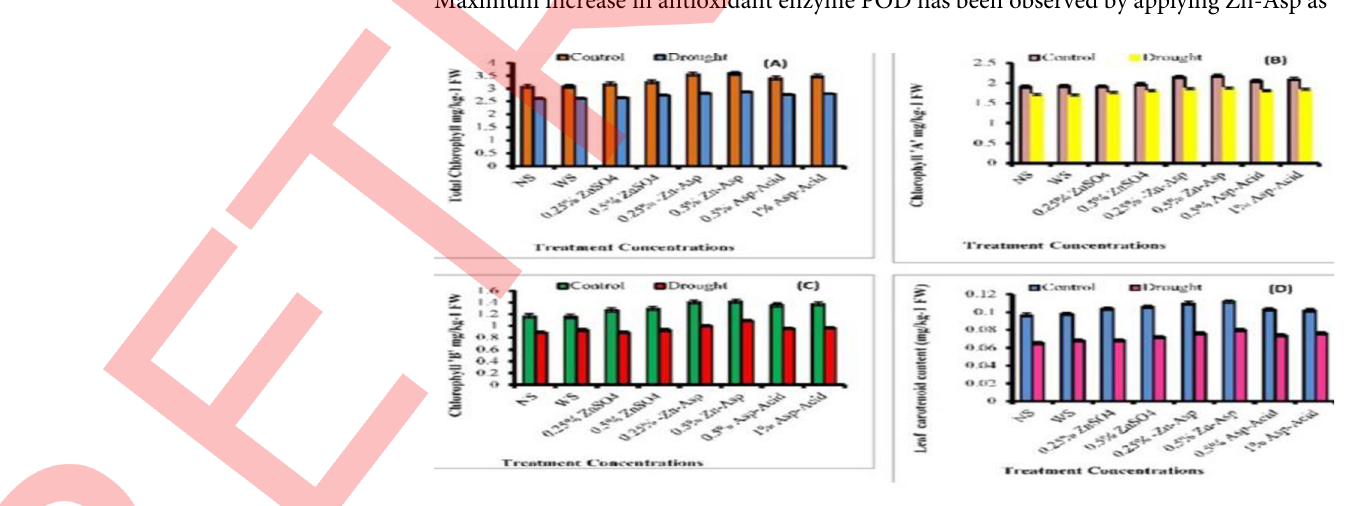
Fig 1. Effect of foliar sprinkled treatments of ZnSO4, Zn-Asp and L-Asp on status of photosynthetic pigments (A) Total Chlorophyll (B) Chlorophyll “A” (C) Chlorophyll “B” and (D) Carotenoid values of maize plants subjected to water stress in comparison with well-watered conditions (mean ± SE; n =